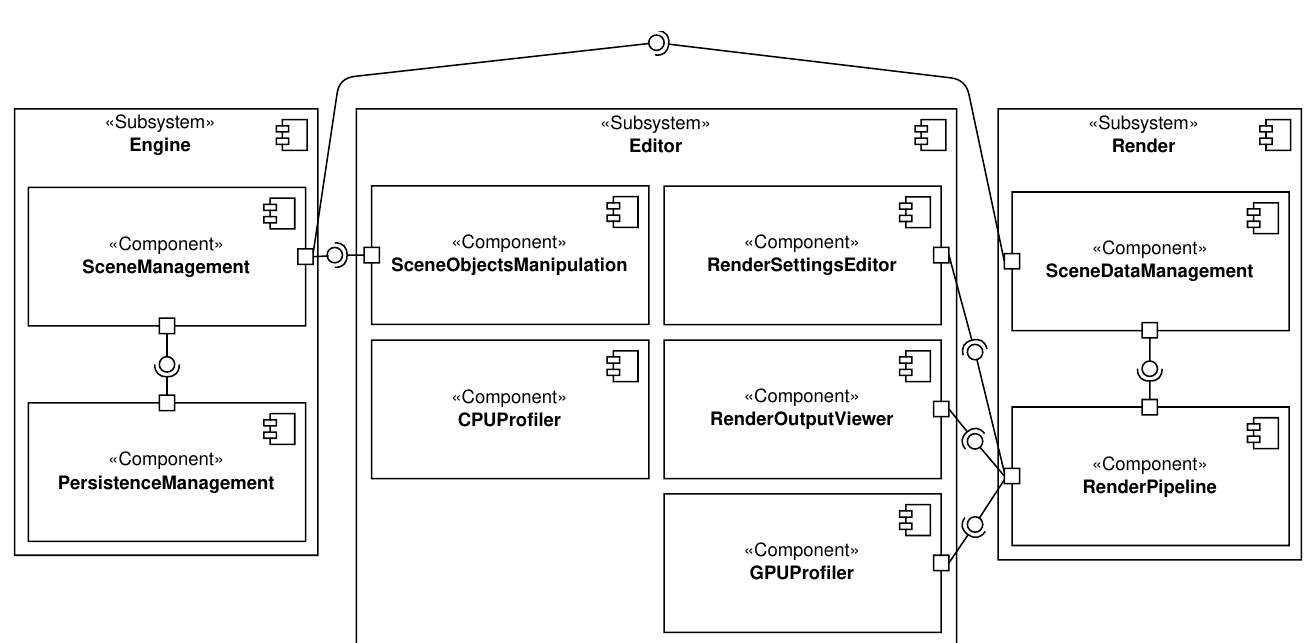
Figure 1. The components diagram of the proposed